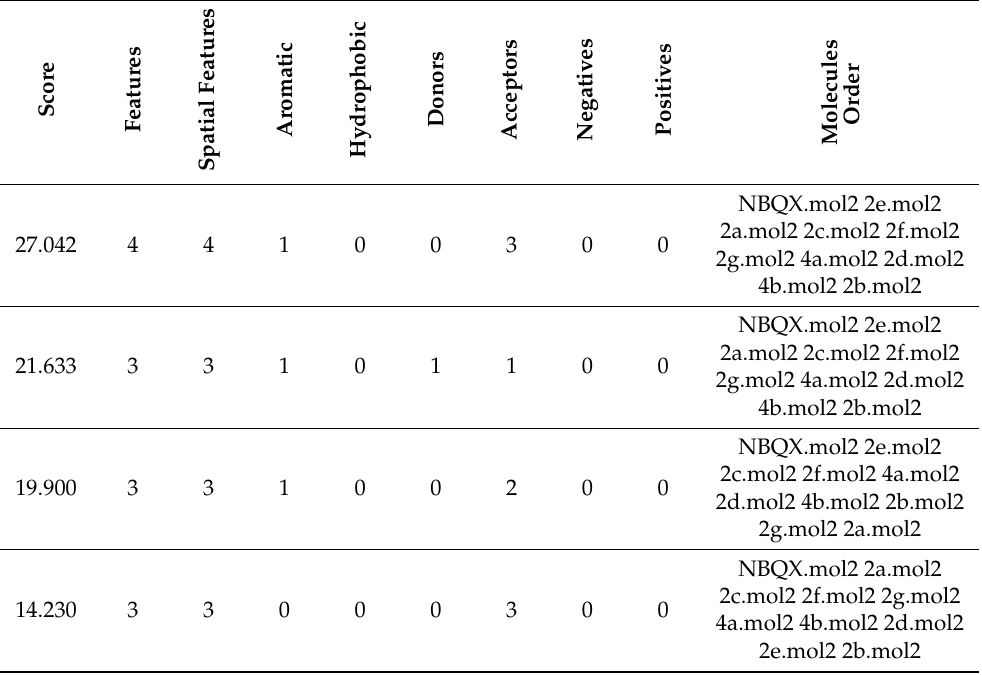
Table 3. Putative Pharmacophore Groups Outcomes, for set2.